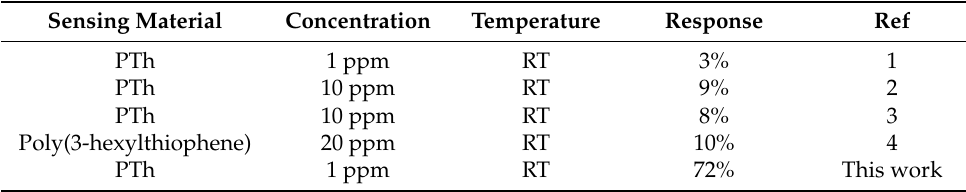
Table 5. NO 2 responses of PTh based gas